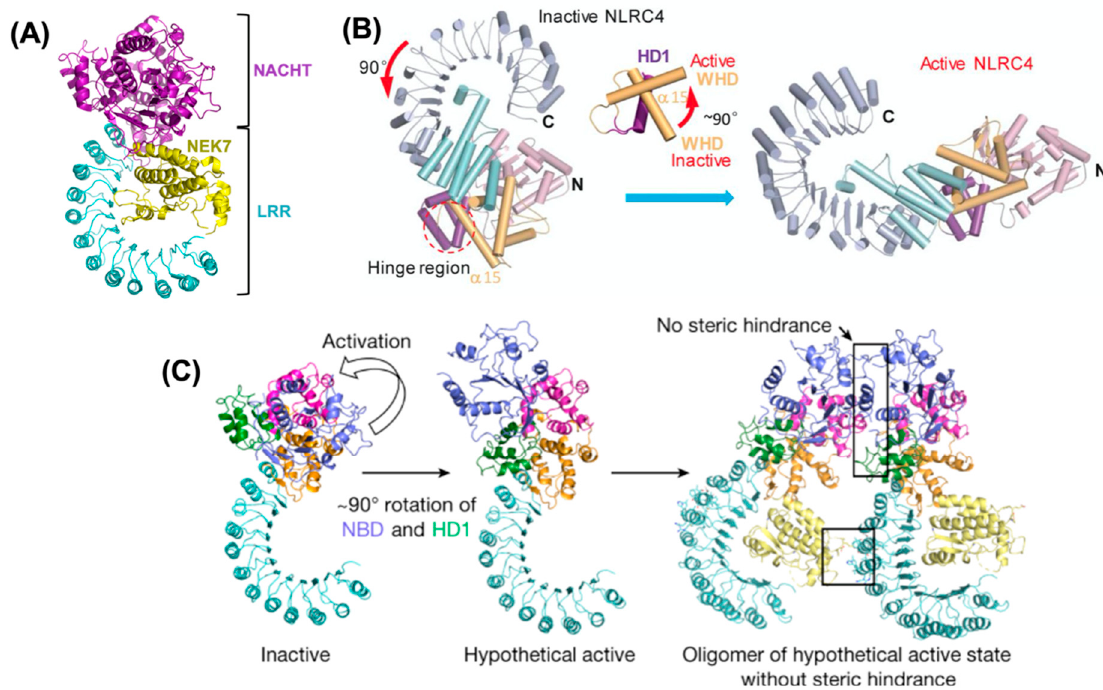
Figure 2. Activation of NLRC4 and NLRP3. ( A ) Cryo-EM structure of leucine-rich repeats (LRR) and NACHT domains of NLRP3 in association with NEK7 (PDB ID: 6NPY) [118]. The ribbon diagram is generated with PyMOL molecular graphics software; ( B ) structural organization and activation of NLRC4. This image is adapted from Figure 2C of [137]; ( C ) modelling of NLRP3 active conformation and NLRP3 dimer formation in association with NEK7. This image is adapted from Figure 5A,B of [118].